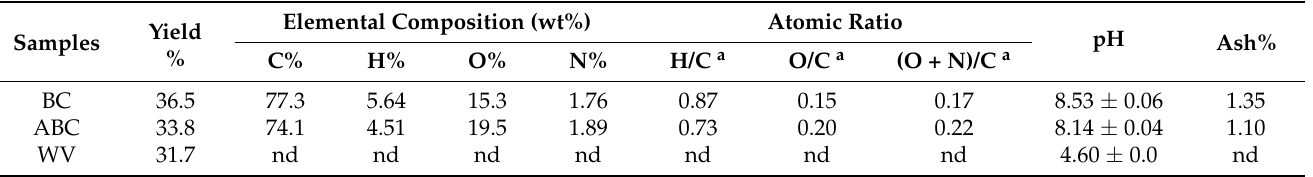
Table 1. Selected characteristics of the sawdust biochar, acid-modified biochar, and wood vinegar.